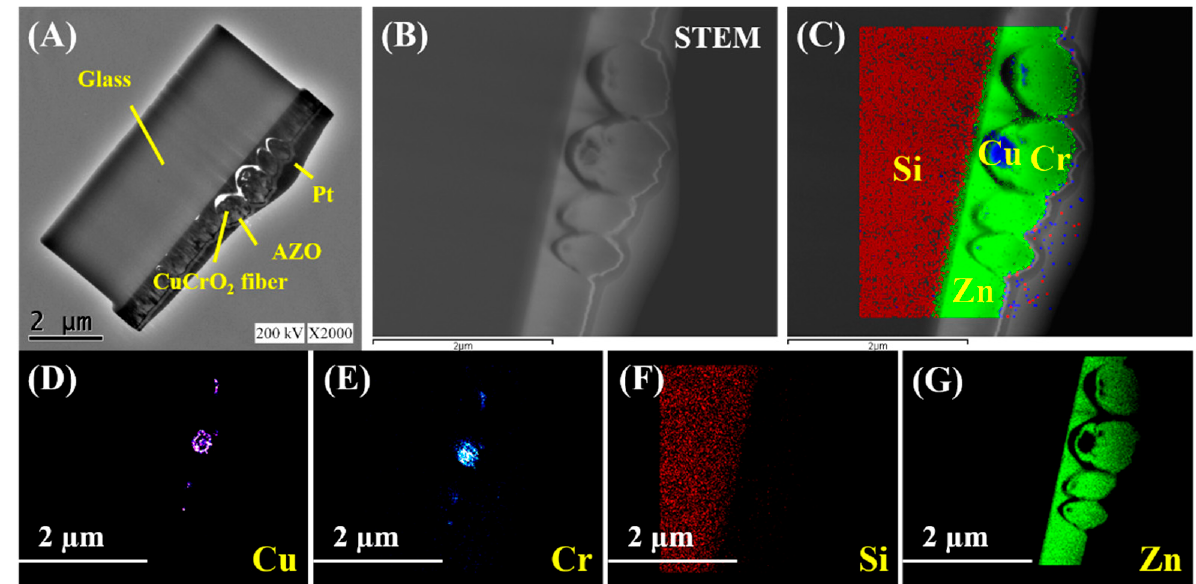
Figure 5. Cross-section FE-SEM of CuCrO 2 thin films deposited on glass substrates at different ro- tating speed and annealed at 600 °C for 10 min. Speed of rotation: ( A ) 100 rpm, ( B ) 500 rpm, ( C ) 1000 rpm, ( D ) 2000 rpm, ( E ) 3000 rpm .